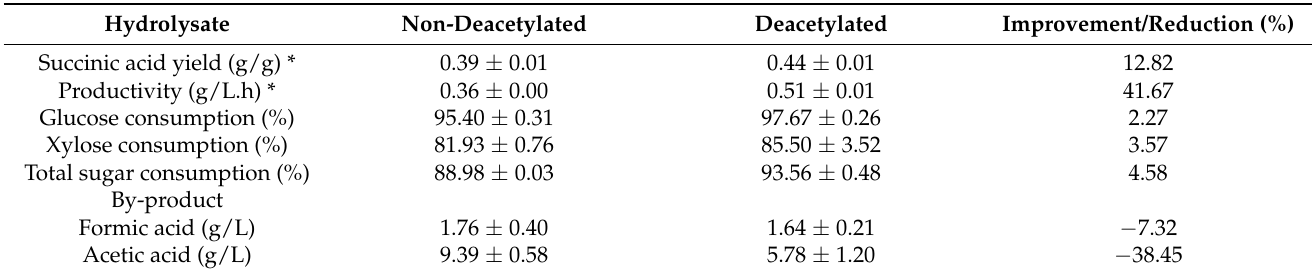
Table 1. Fermentation parameters of succinic acid production by A. succinogenes 130Z using acid- pretreated oil palm trunk hydrolysate for 48 h of